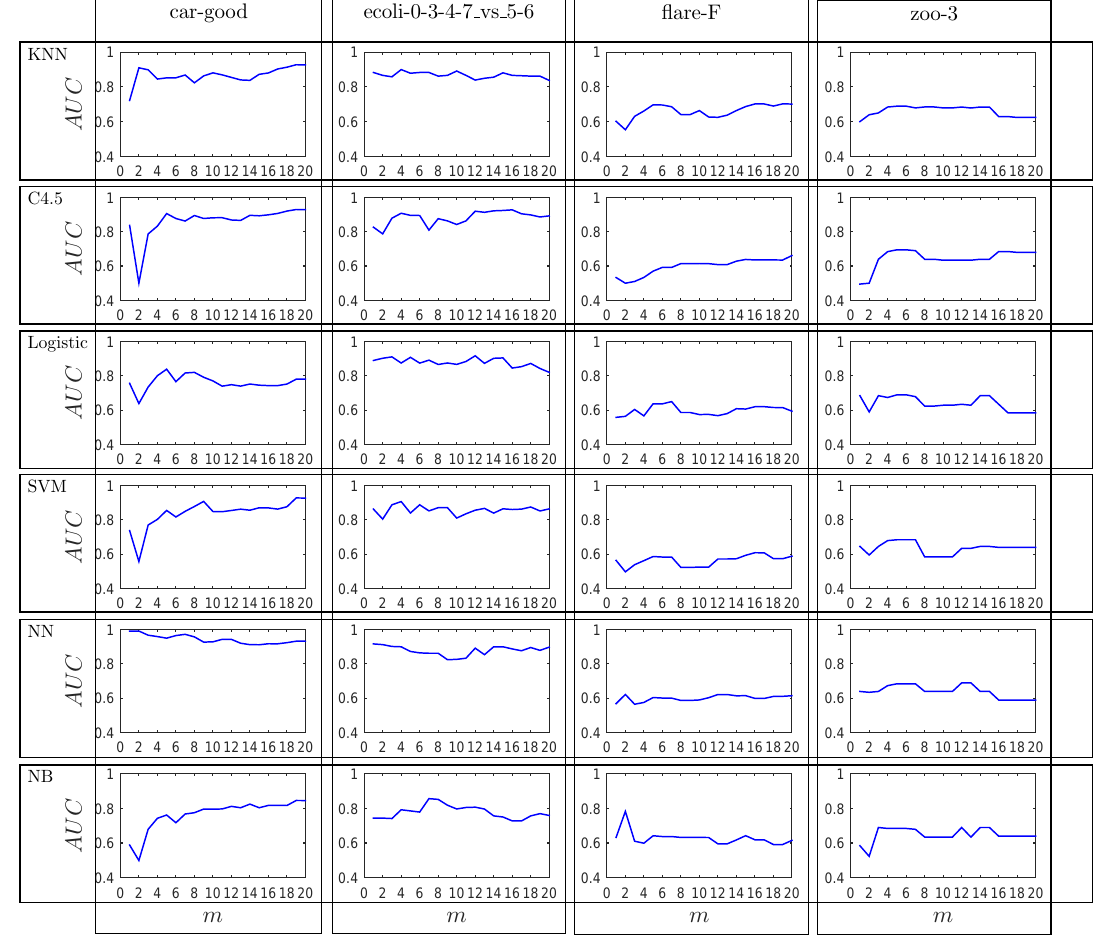
Figure 3. Impact of parameter m on the performance of